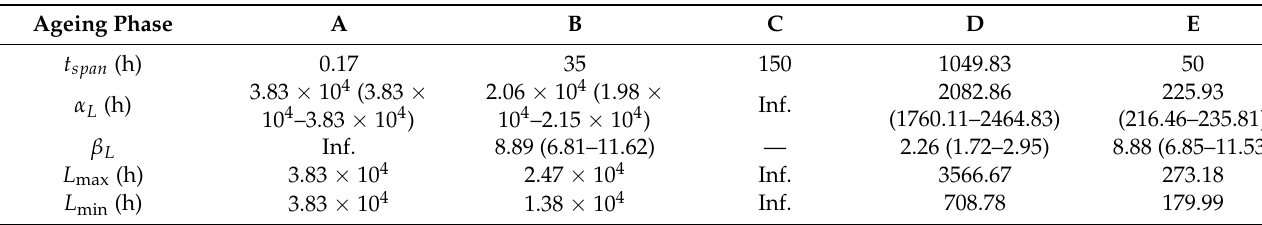
Table 3. Parameters of the Weibull function fitted to the life estimations from simulation results at each ageing phase as well as their maximum and minimum